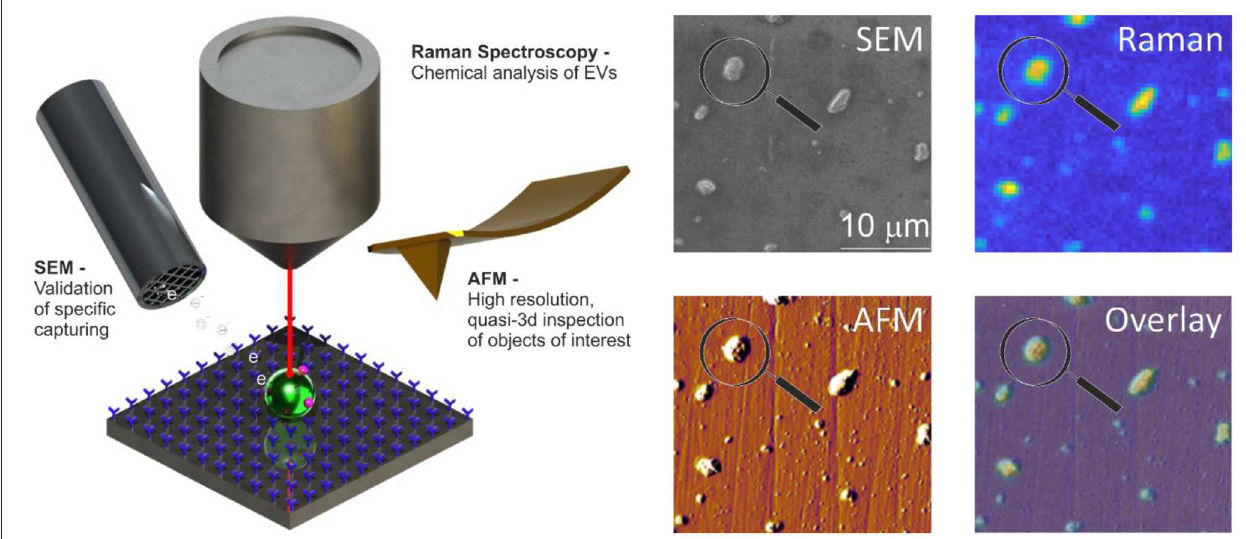
FIGURE 8 | Atomic force microscopy (AFM), scanning electron microscopy (SEM), and Raman spectroscopy of extracellular vesicle (EV) sample. Schematic representation of the system: antibody-functionalized stainless-steel substrate examined with SEM, AFM, and Raman for correlated multimodal analysis of individual EVs. Image adapted from Beekman et al. (